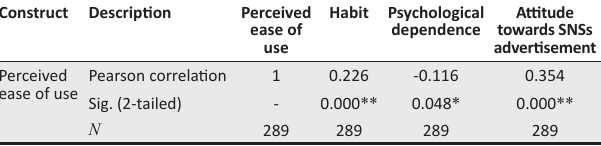
TABLE 3: Correlation test result.